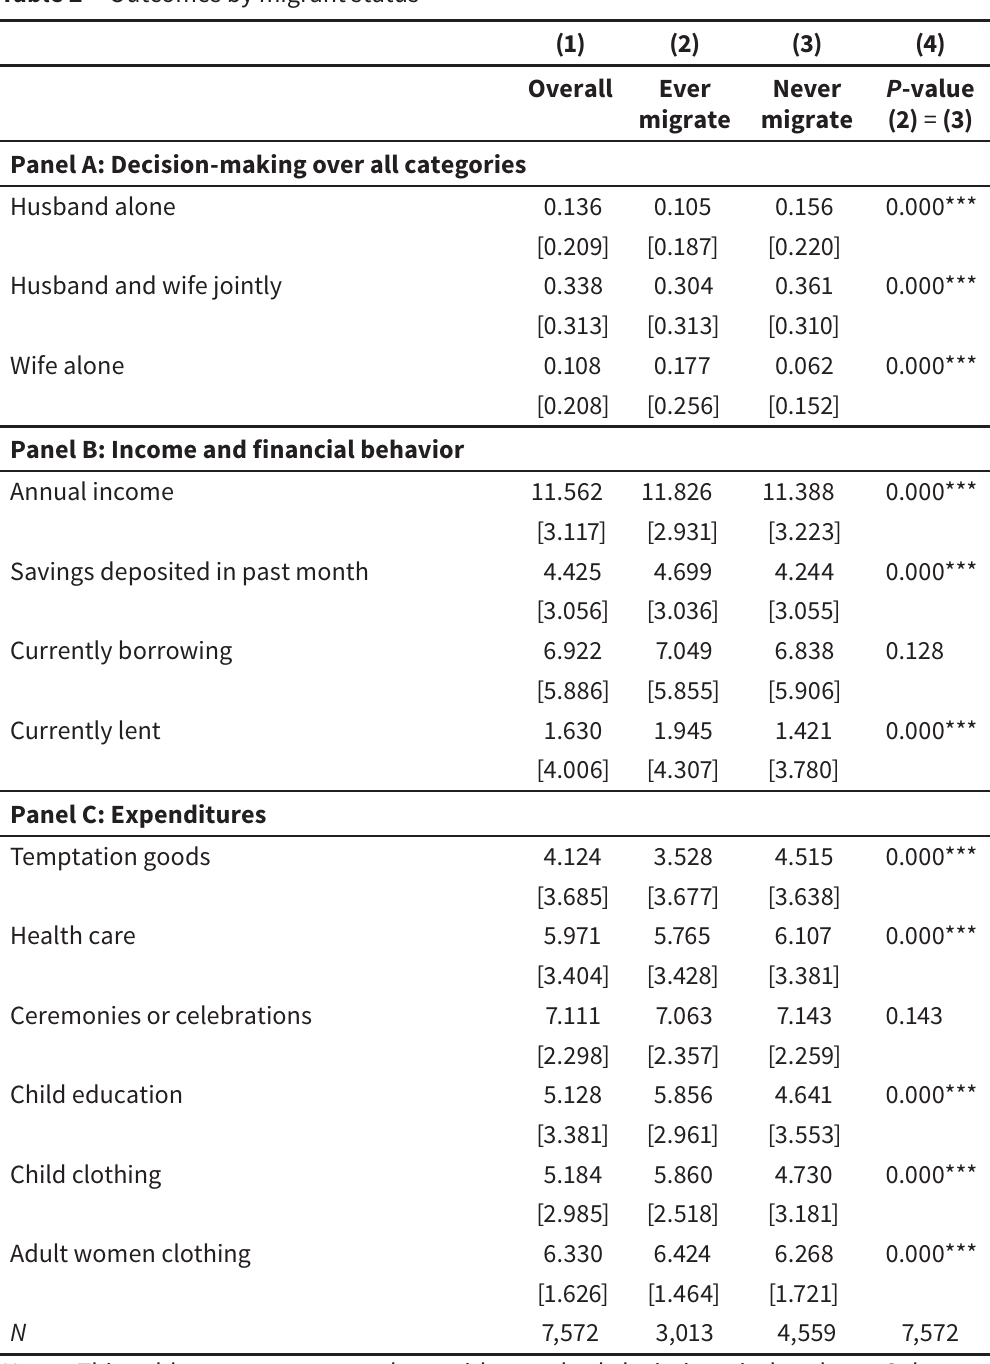
Outcomes by migrant status